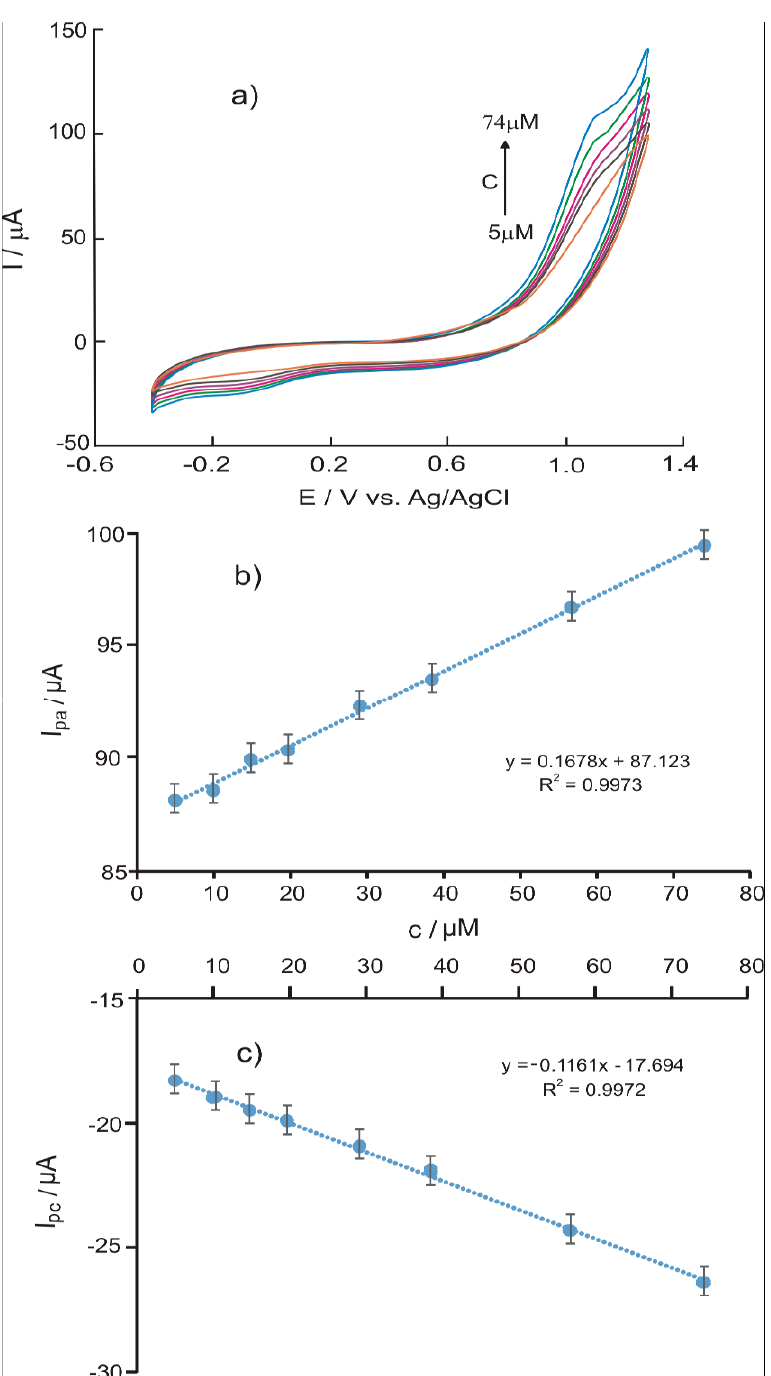
Figure 5. ( a ) Overlapping cyclic voltammograms of the SPCE/HRP biosensor, immersed in different solutions with variable concentrations of caffeic acid (electrolyte support was 10 − 2 M PBS pH 7–10 − 2 M hydrogen peroxide solution); ( b ) plot of linear calibration of the SPCE/HRP biosensor for caffeic acid based on anodic peak currents; and ( c ) plot of linear calibration of the SPCE/HRP biosensor for caffeic acid based on cathodic peak currents.